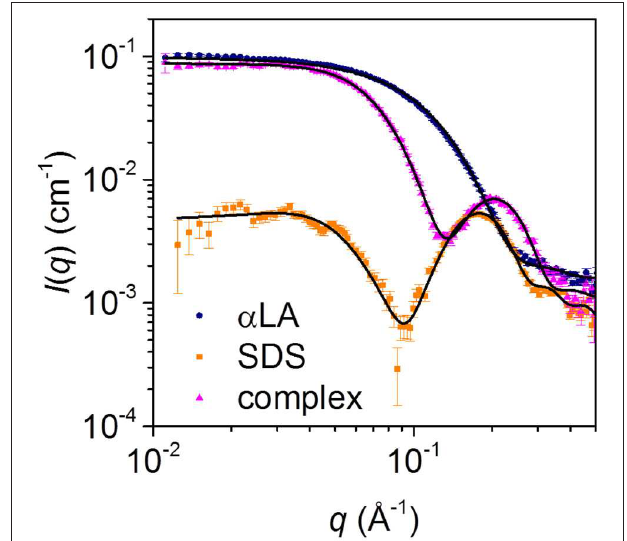
FIGURE 4 | SAXS data for solutions of 28mM SDS (orange squares), 0.7mM aLA (blue circles) and a 1:1 mixture of the two (pink triangles), resulting in an SDS:aLA mixing ratio of 40.